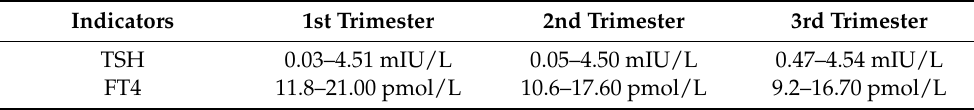
Table 1. Reference ranges for serum TSH and FT4 during pregnancy in Chinese women.